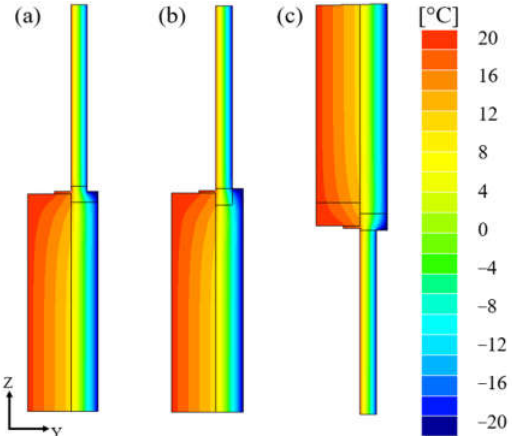
Figure 11. Sample temperature distribution, wall sections for model 1.1.1: ( a ) bottom, ( b ) side, ( c ) top.